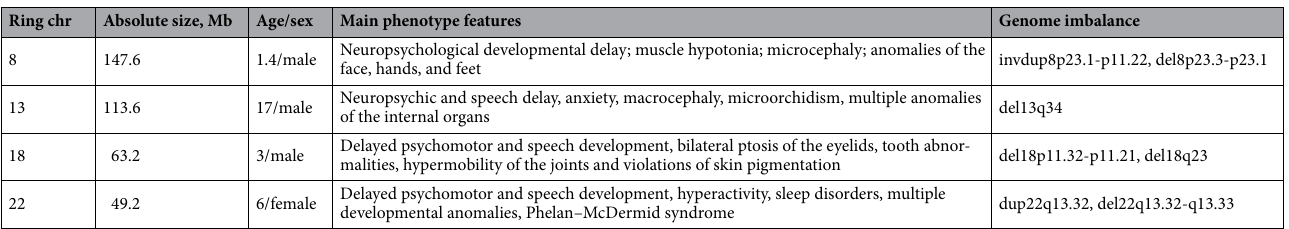
Table 1. Cytogenetic and molecular findings in patients with ring